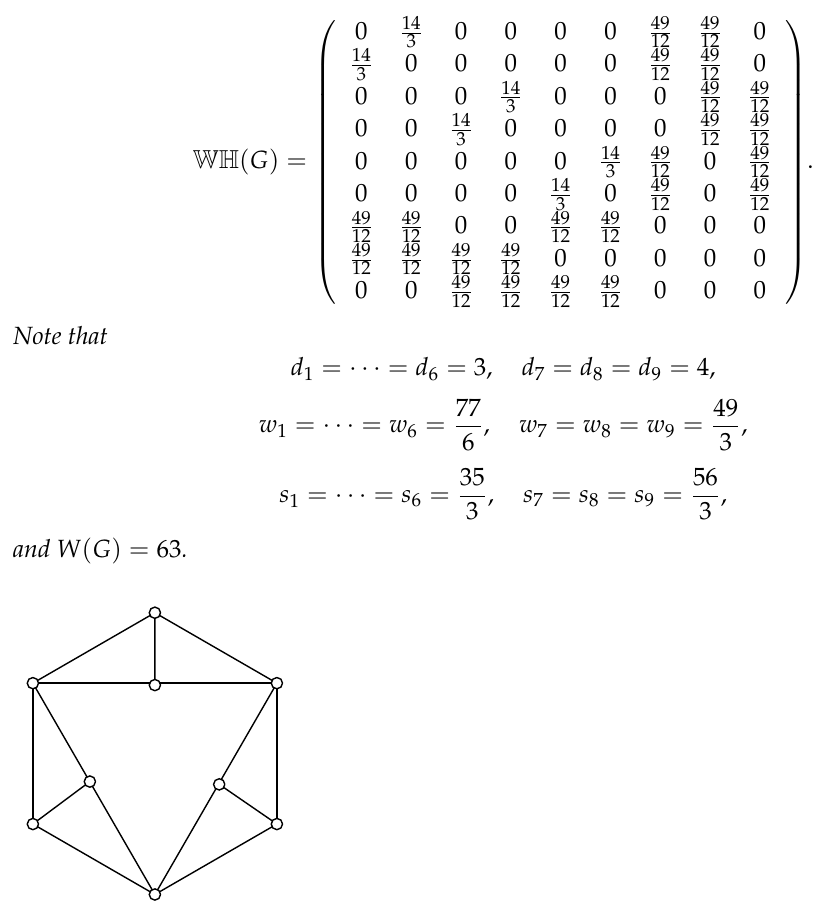
Figure 1. A 14-transmission regular graph which is not vertex-degree